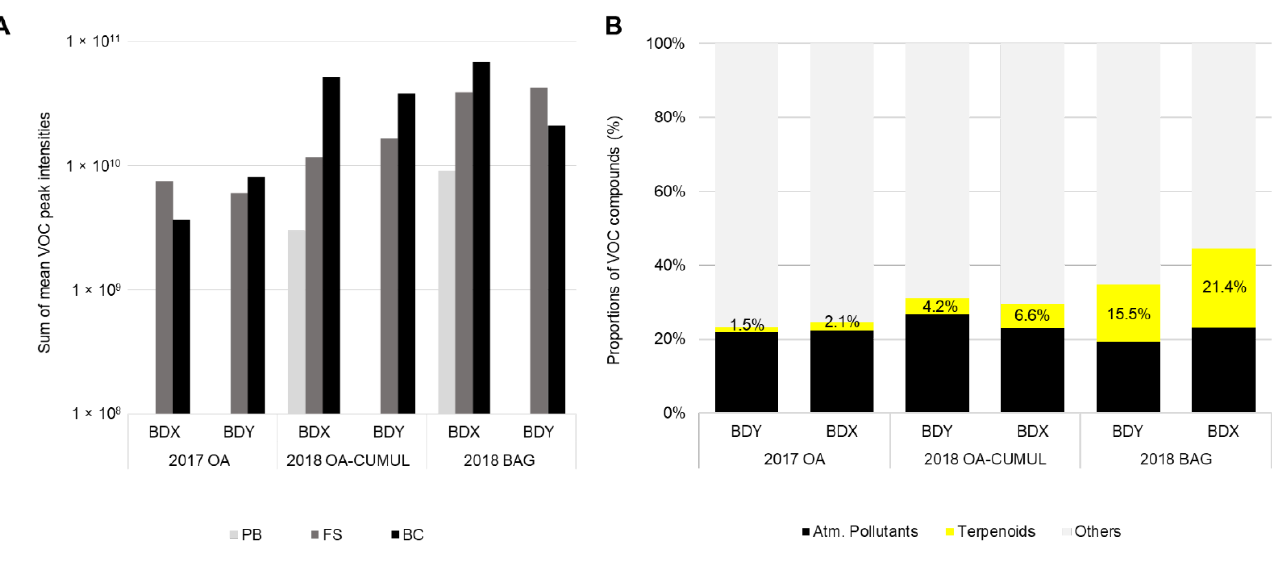
Figure 3. Intensity and diversity of VOCs collected by three collection methods. Three different modes of VOC collection — open-air (OA), open-air cumulated (OA-CUMUL) or bagged (BAG) — were compared in 2017 and 2018 in two vineyards (Burgundy, cv. Chardonnay, Bordeaux, cv. Cabernet franc). ( A ) Sums of the peak area intensities calculated from H 2 O-treated grapevines at three phenological stages (pre-blossom: PB; fruit-set: FS and bunch-closure: BC). ( B ) Distribution of the 100 most counted elemental formulas recorded from Bastid ® - and H 2 O-treated vines. Vineyards: Bordeaux: BDX; Burgundy: BDY.